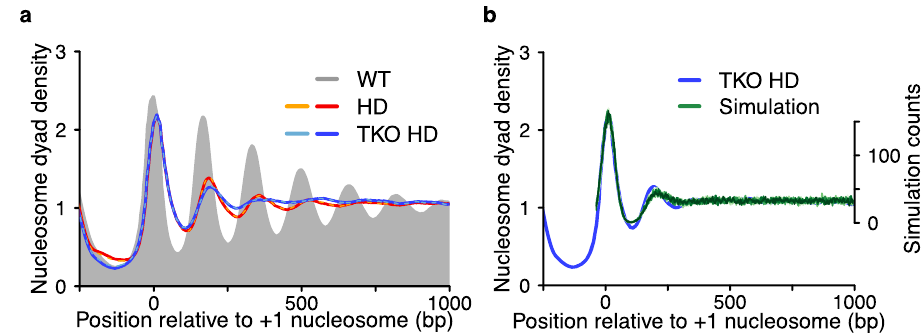
nucleosome organization of ~5000 genes before (WT; grey) and after histone depletion in otherwise wild-type (HD) or TKO cells (TKO HD). All